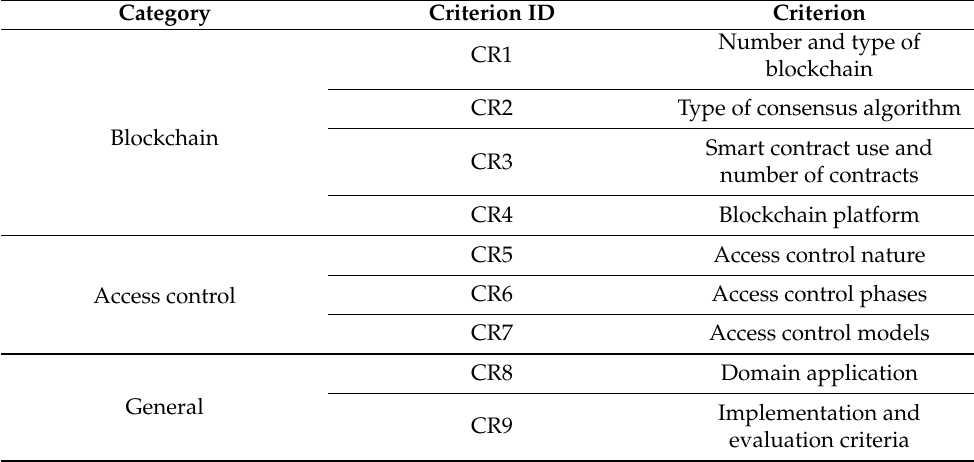
Table 2. Evaluation criteria.